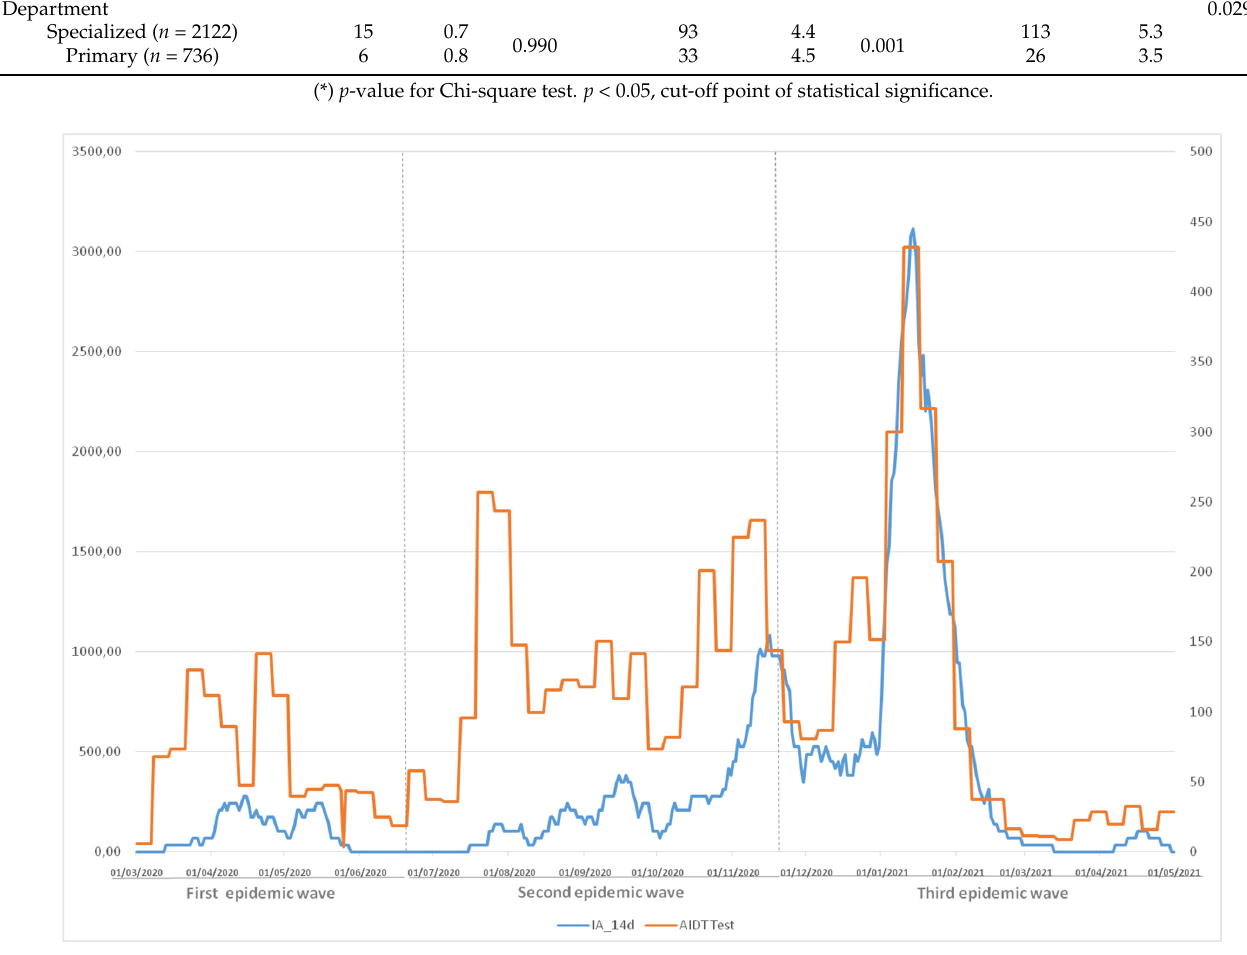
Figure 1. Evolution of the cumulative incidence rate (AI) and number of requests for diagnostic tests of active infection (AIDT) for SARS-CoV-2. AI 14 days/100,000 inhabitants. Number of AIDT